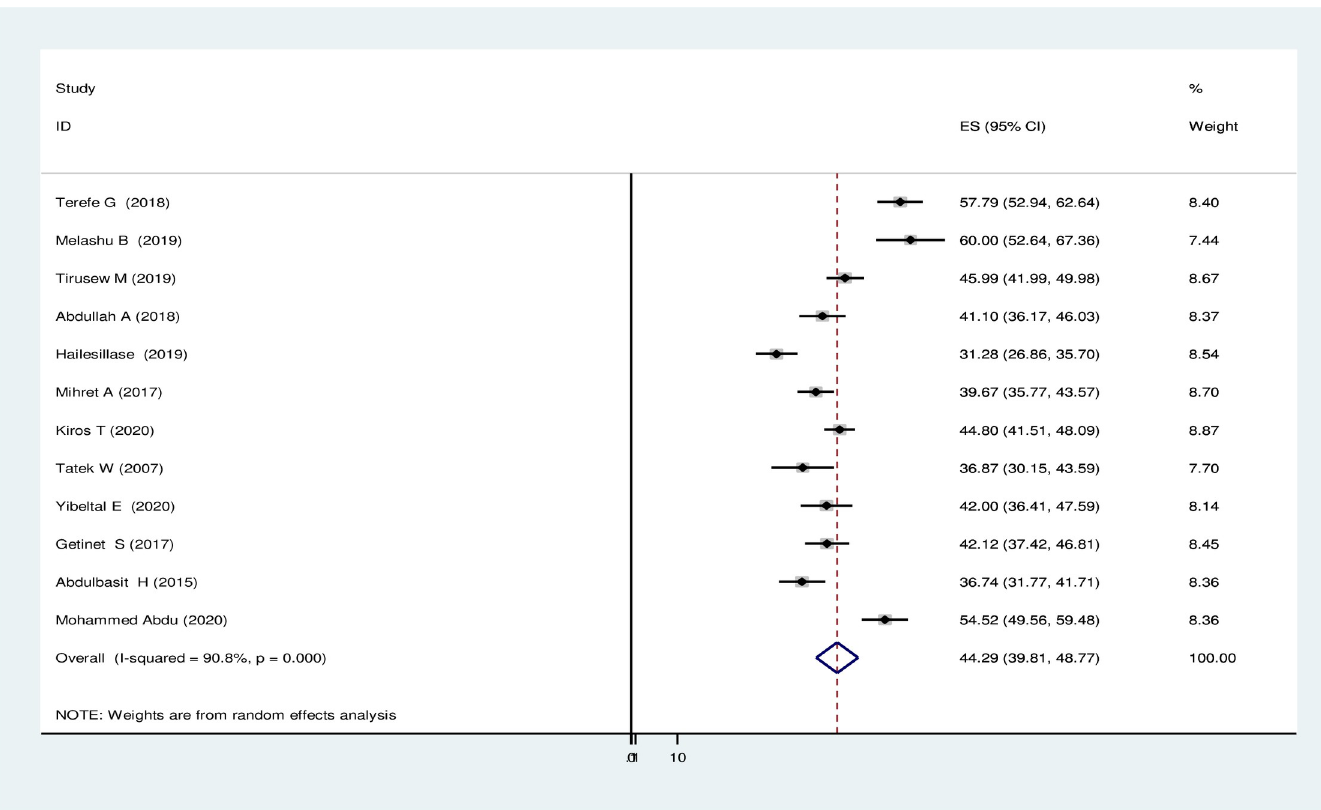
Fig 2. Pooled prevalence of treatment seeking delay in seeking health service delivery among tuberculosis patients in Ethiopia, 2020.